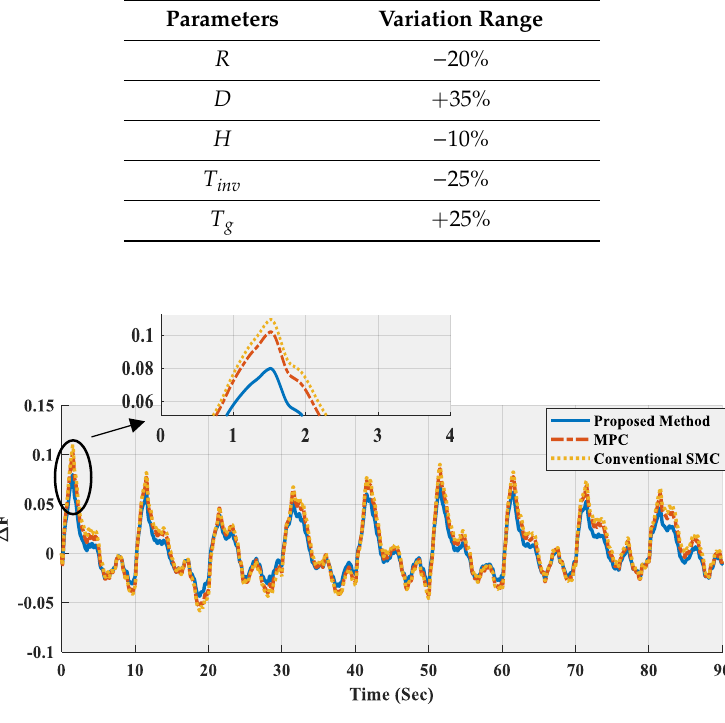
Figure 8. Curves of the MG response according to Case 2.